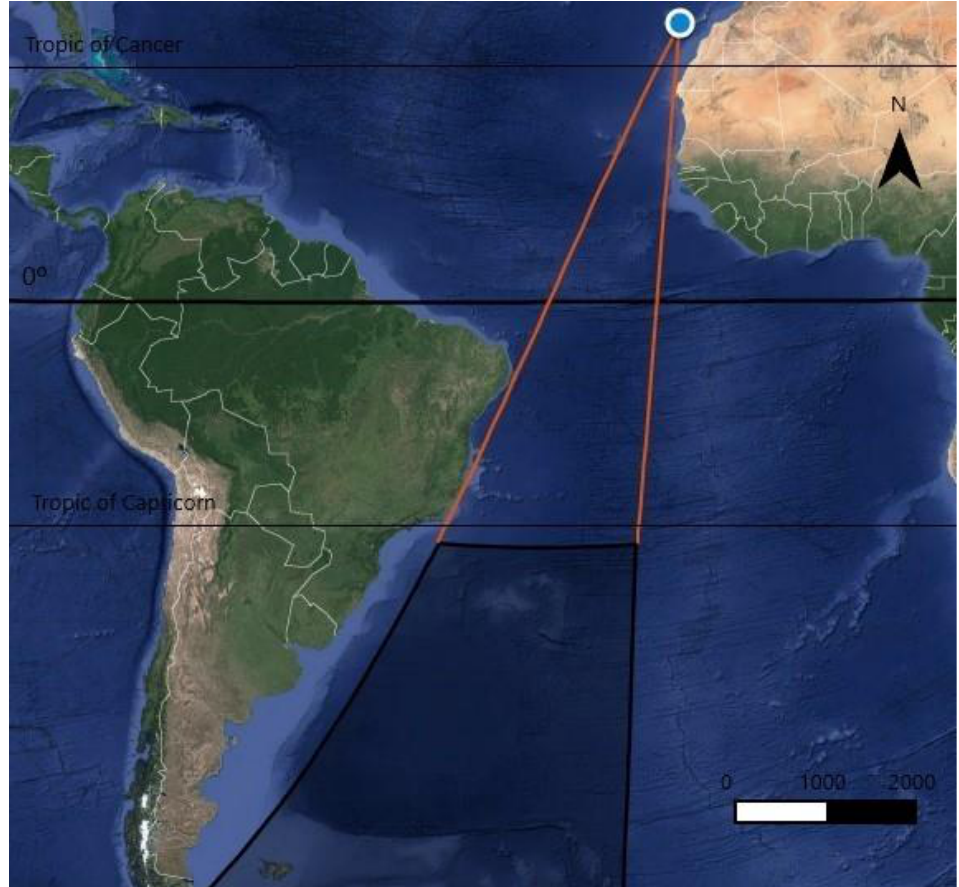
Figure 6. Buoy location (white–blue) and geodesic paths defined by the South Atlantic basin passing through it (the hatched area is the likely region of origin of the swells). Scale in Km.